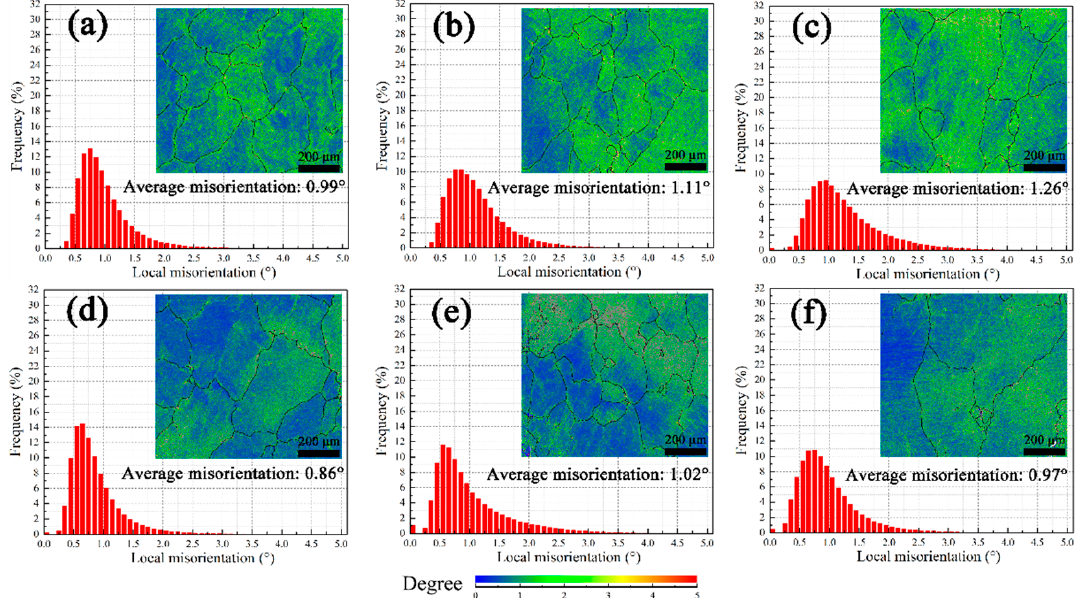
Figure 5. KAM maps of Al-Cu-Li alloy after 12 h creep, pre-treatment: ( a ) 3#, ( b ) 6#, ( c ) 9#, ( d ) 3A#, ( e ) 6A#, ( f ) 9A#.